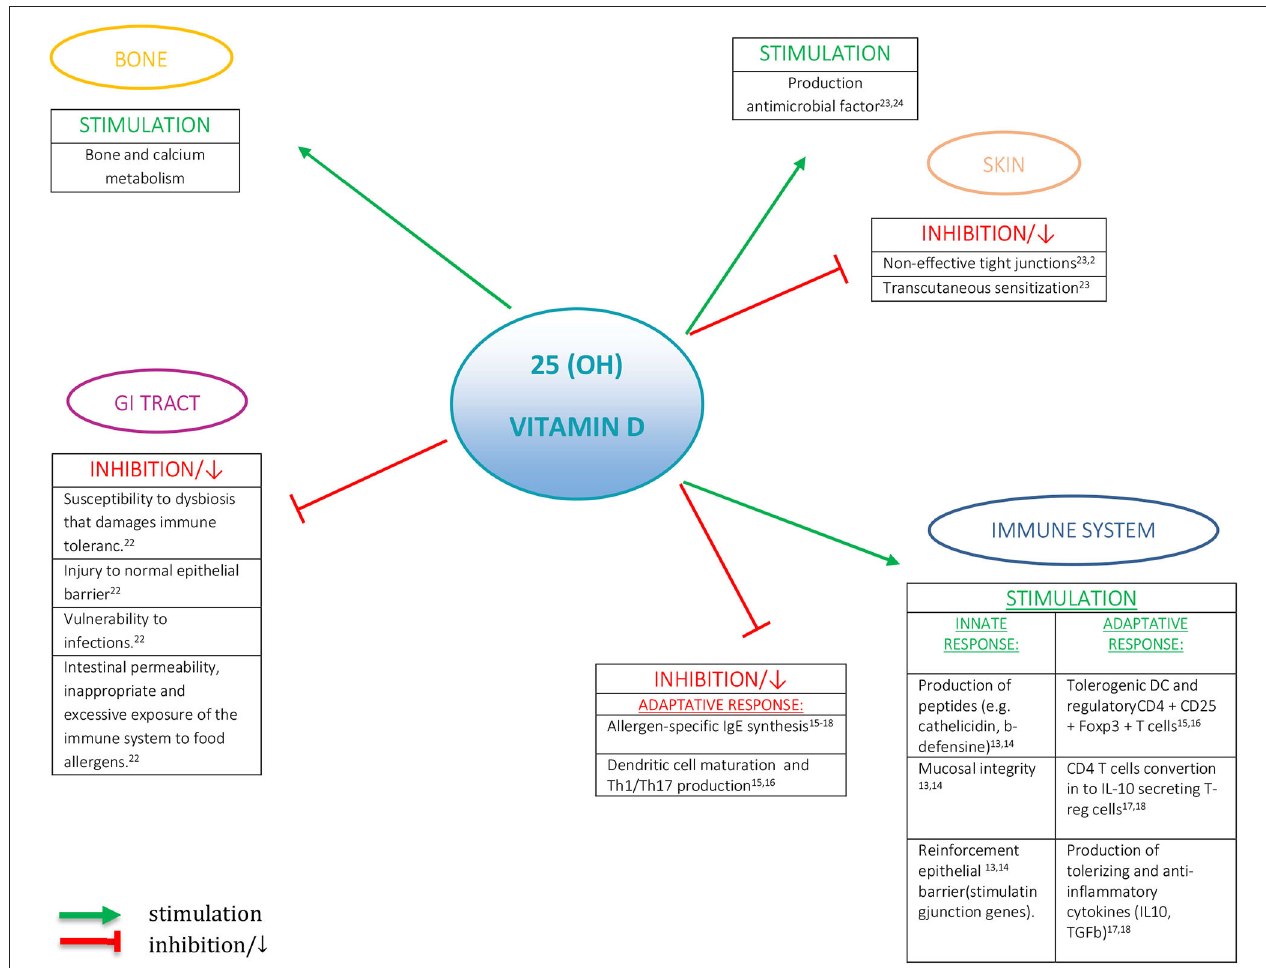
FIGURE 1 | The role of vitamin